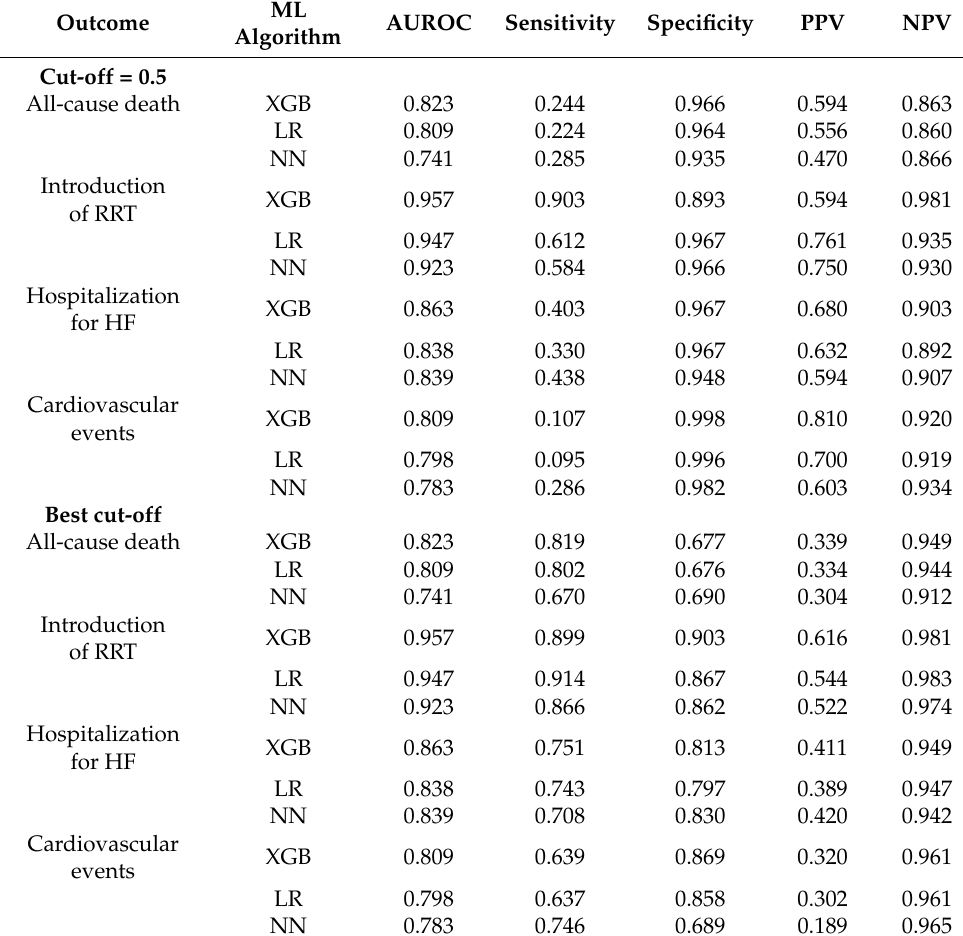
Table 2. Prediction performance of the machine learning models on the internal validation